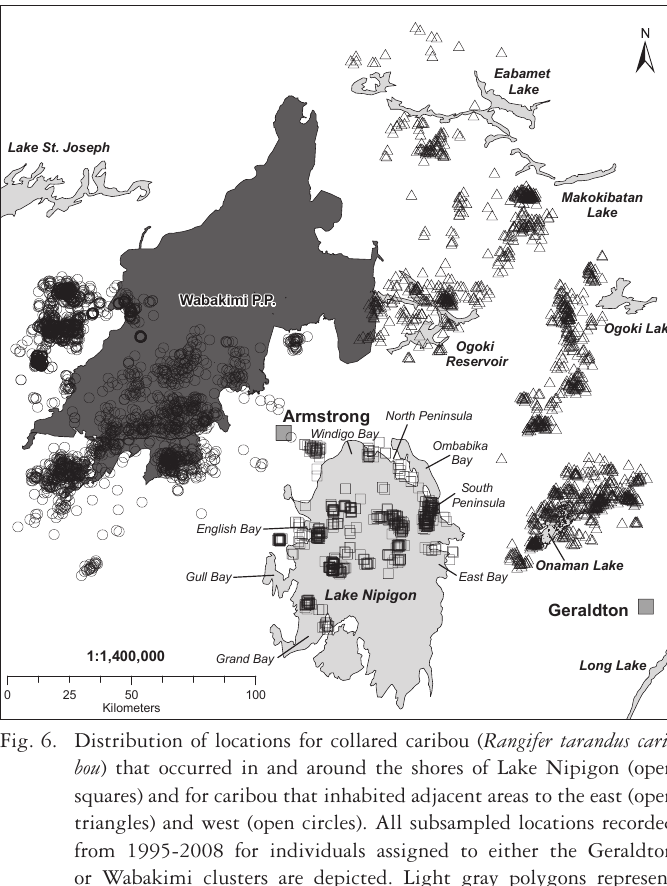
Fig. 6. Distribution of locations for collared caribou ( Rangifer tarandus cari- bou ) that occurred in and around the shores of Lake Nipigon (open squares) and for caribou that inhabited adjacent areas to the east (open triangles) and west (open circles). All subsampled locations recorded from 1995-2008 for individuals assigned to either the Geraldton or Wabakimi clusters are depicted. Light gray polygons represent major waterbodies. The dark gray polygon located to the west of Lake Nipigon depicts the boundaries of Wabakimi Provincial